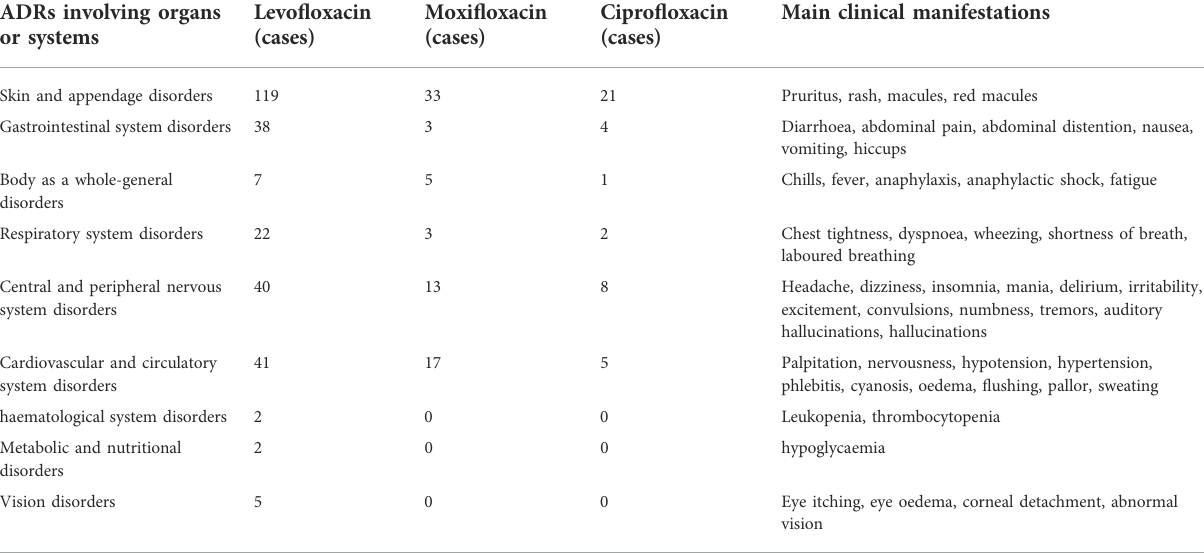
TABLE 4 Signal detection results of adverse drug reactions with levo fl oxacin, moxi fl oxacin, and cipro fl oxacin analysed using four signal mining algorithms.